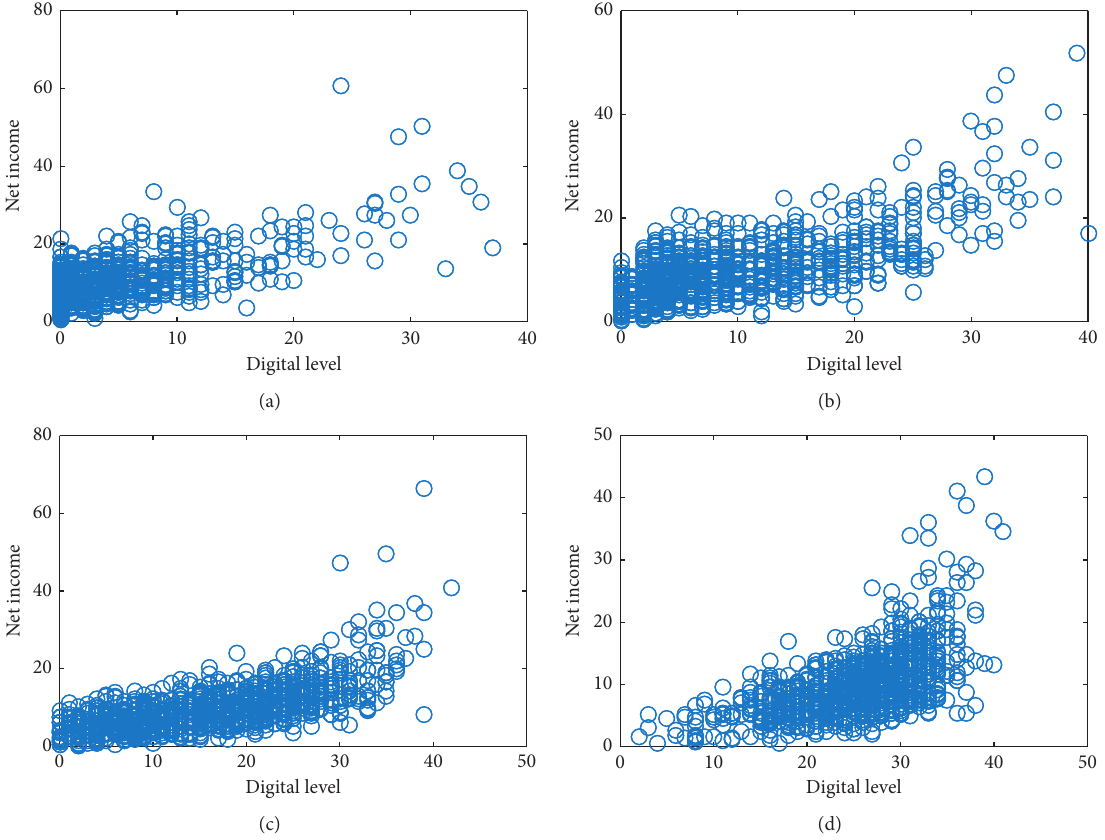
Figure 4: Enterprises’ net income under different transformation costs: (a) Cu � 2, Cb � 4; (b) Cu � 1.5, Cb � 3; (c) Cu � 1, Cb � 2; (d) Cu � 0.5, Cb �